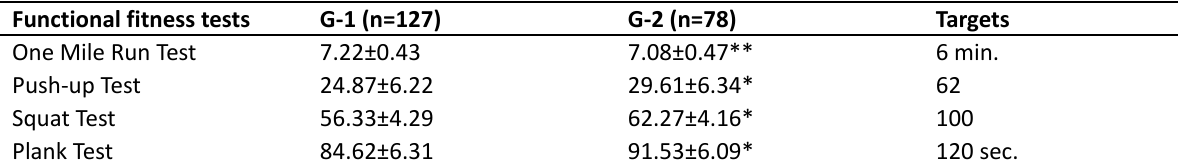
Table 2. The results of Functional fitness assessment tests of students (G-1 and G-2). Functional fitness tests